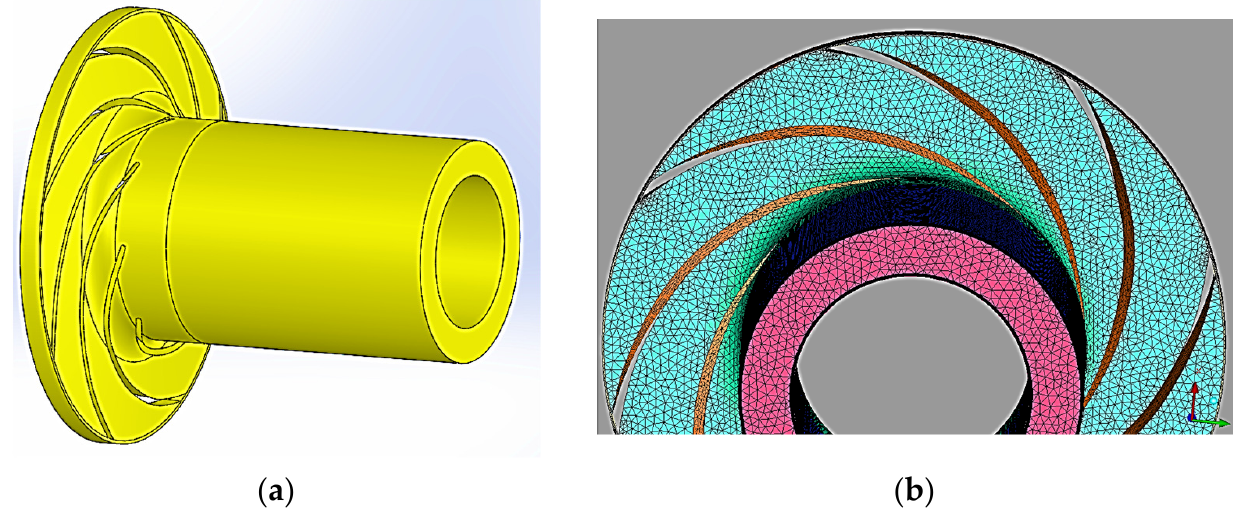
Figure 3. 3D model ( a ) and CFD grid ( b ) of the flow part.